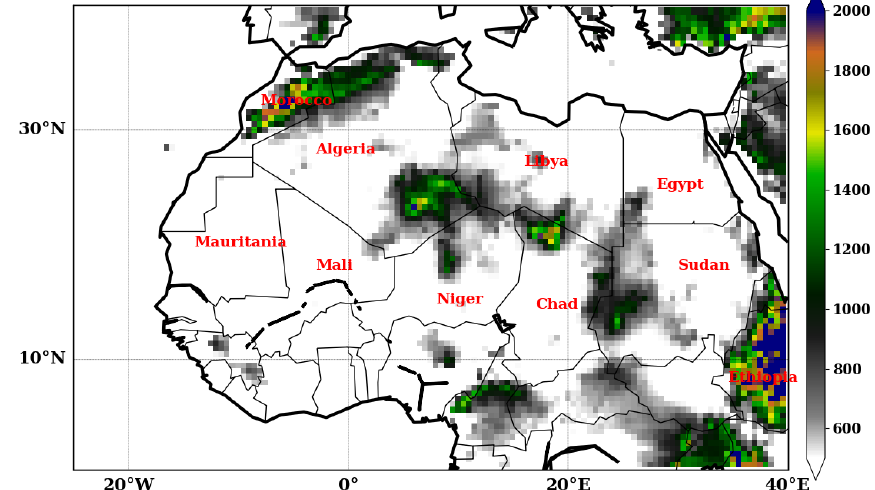
Figure 1. Topographic map of West Africa using ERA5 elevation data. The y axis and x axis represent the latitude and longitude respectively, in degrees over the domain. The color bar shows the elevation in meters over the